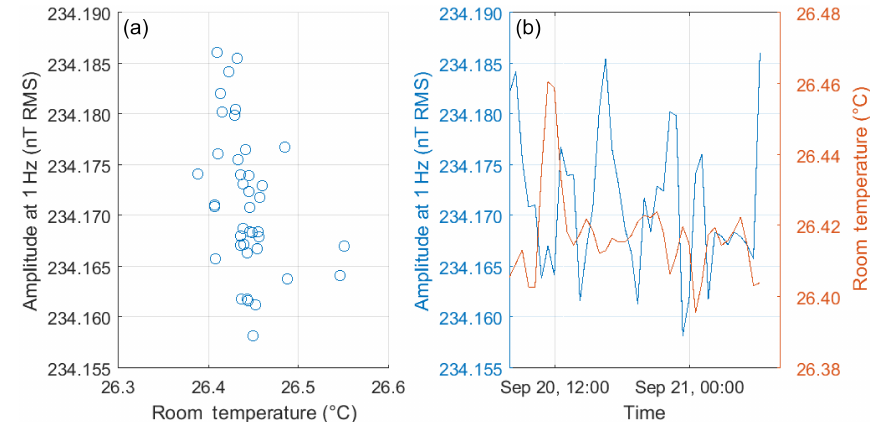
Figure 14. (a) Measured signal amplitude plotted against room temperature. (b) Measured signal amplitude and room temperature over time. The measured signal amplitude was found to have a weak, but non-zero, anti-correlation with room temperature ( R = − 0 . 38, R 2 = 0 . 15, p = 0 .